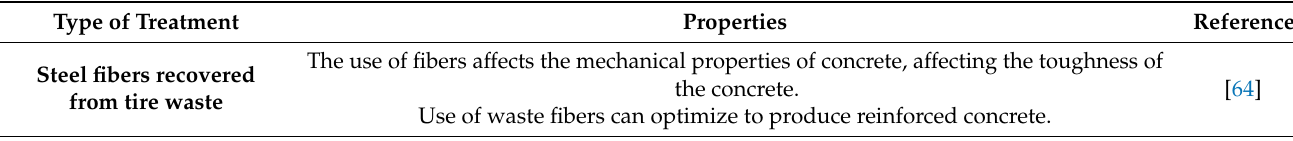
Table 7. Some treatments with the most significant properties of synthetic